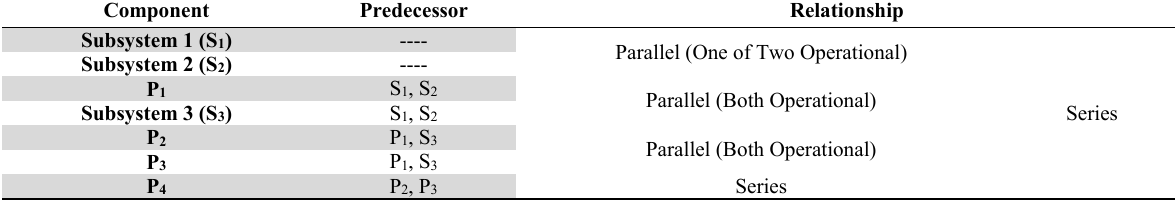
The direct predecessors for each one, and the relationship between the components Component